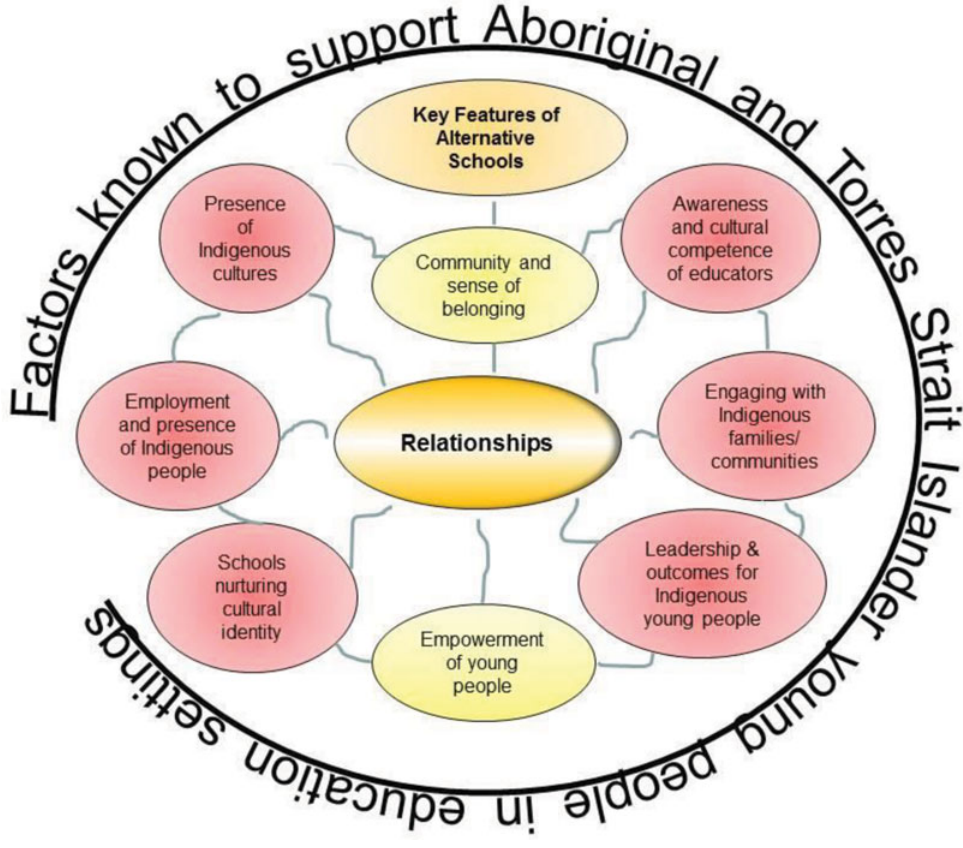
(Colour online) Alternative schools and Aboriginal and Torres Strait Islander learners (Shay,